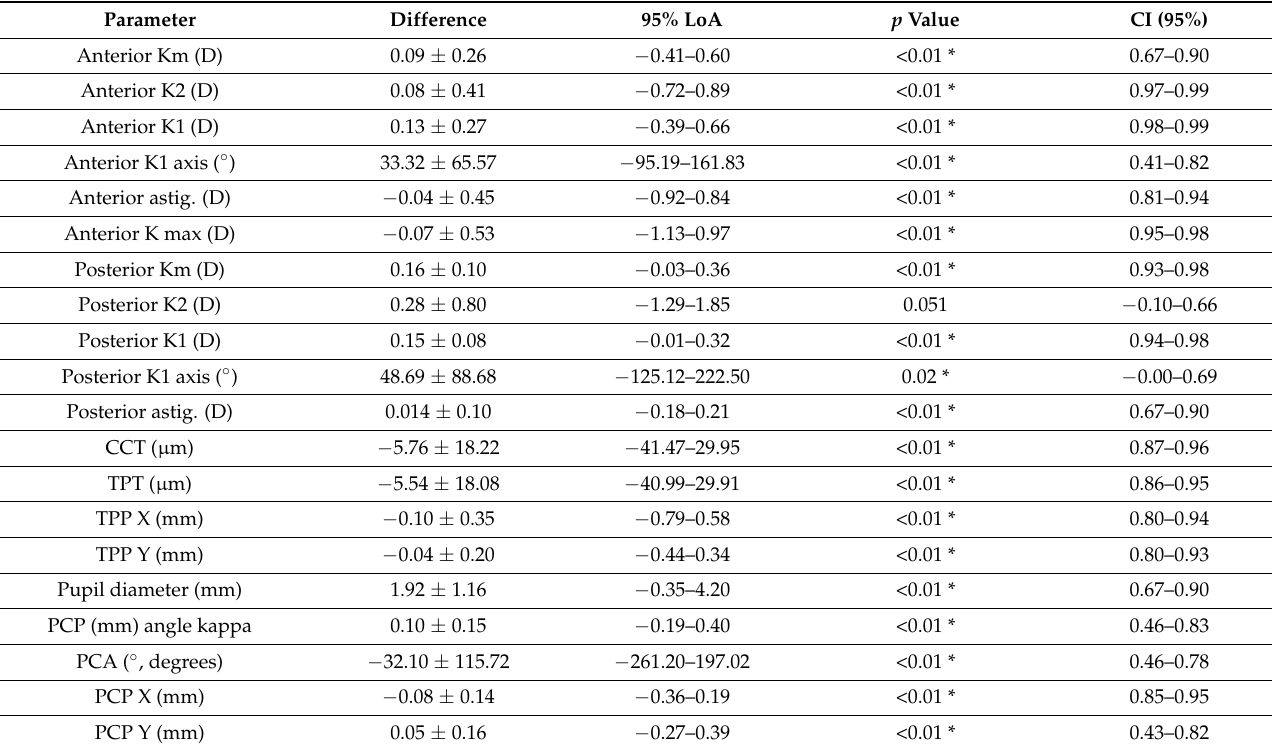
Table 2. Inter-device measurement agreement between Anterion and Pentacam